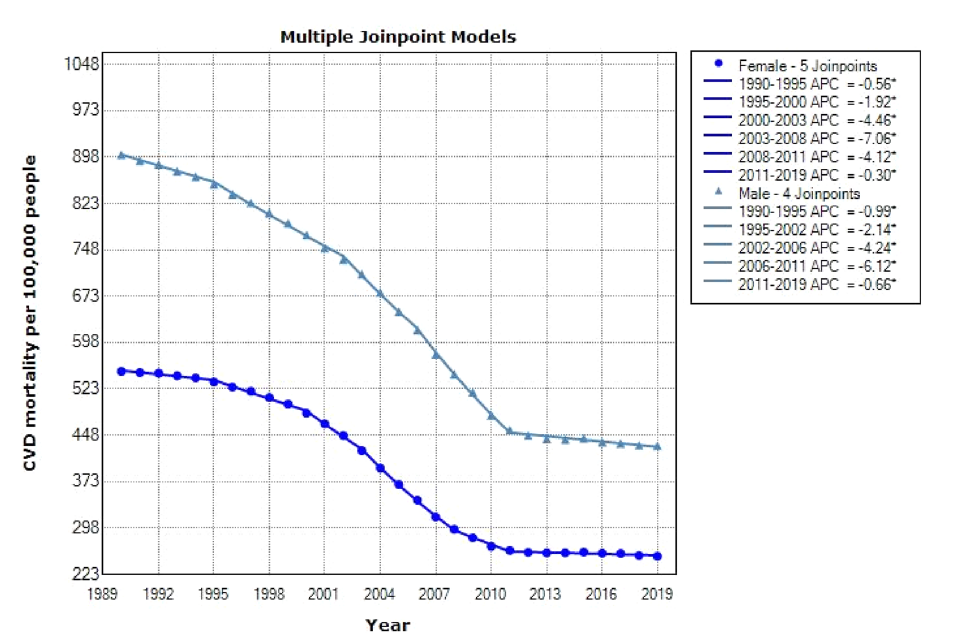
Figure 3. Jointpoint regression model for CVD mortality aged 50–69 by gender: